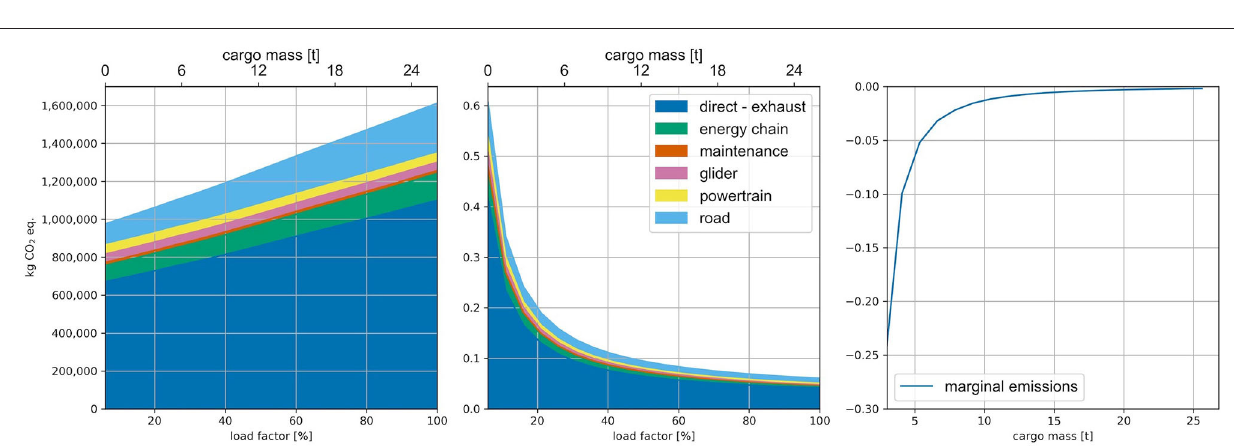
FIGURE 4 | Upscaling scenarios for transportation with a 40-ton diesel truck. Left: Total Global Warming impact in kg CO 2 -eq as a function of the capacity utilization. Center: Global Warming impact in kg CO 2 -eq/tkm as a function of capacity utilization. Right: Change Global Warming impact in kg CO 2 -eq/tkm as a function of cargo